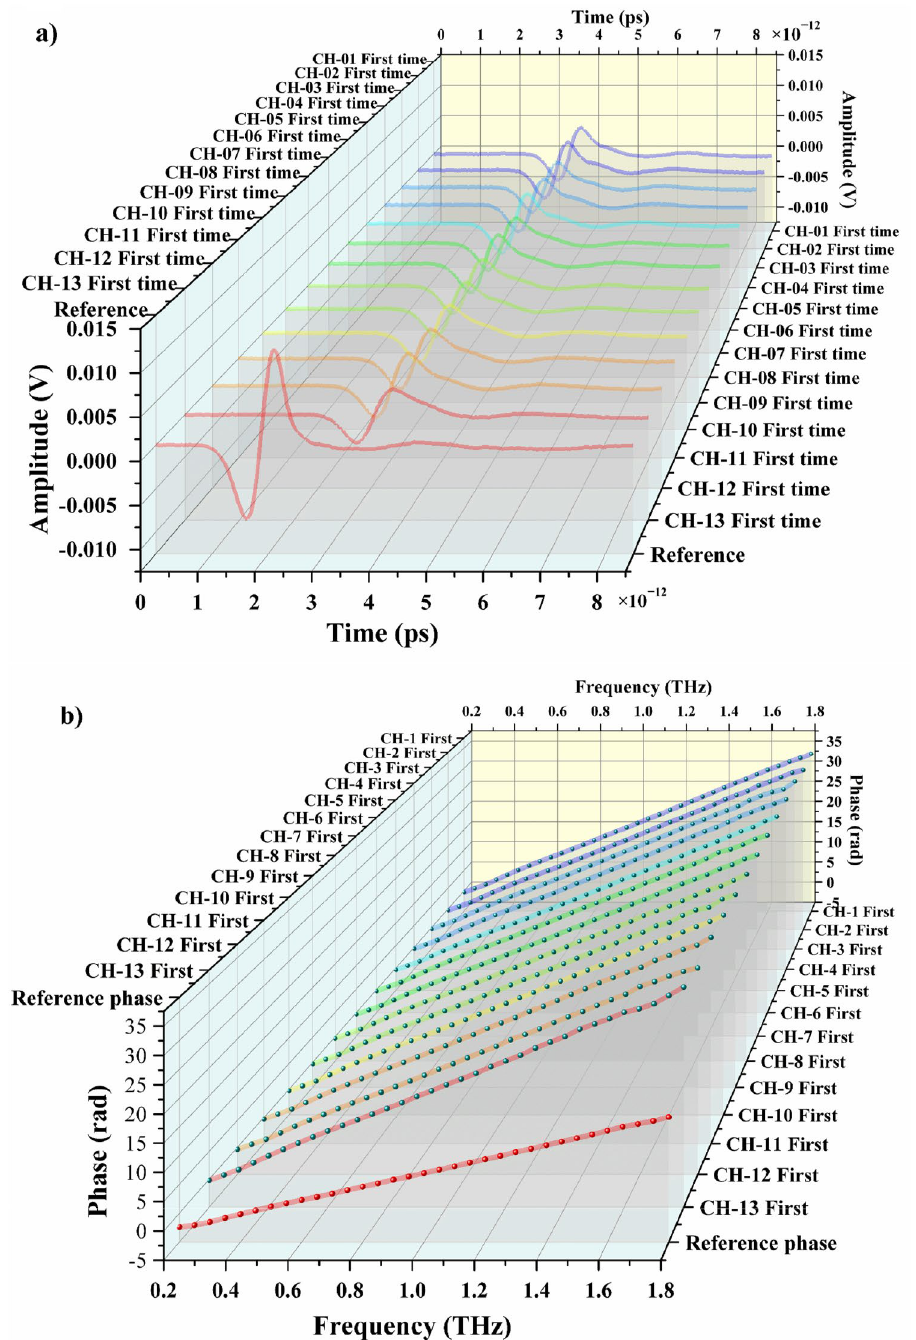
Figure 2. Results of terahertz measurements on bentonite samples. THz-TDS diagrams ( a ). THz-TDS phase diagrams obtained in the first test of all samples ( b ). THz-TDS phase diagrams obtained in the second test of all samples ( c ). Frequency-domain spectra obtained in the absorption by bentonite samples with different weights at different concentrations of trivalent chromium ions ( d ). The experiments were carried out at the temperature of 293.15–298.15 K, the pressure of one atmosphere and the humidity of air inside the setup <